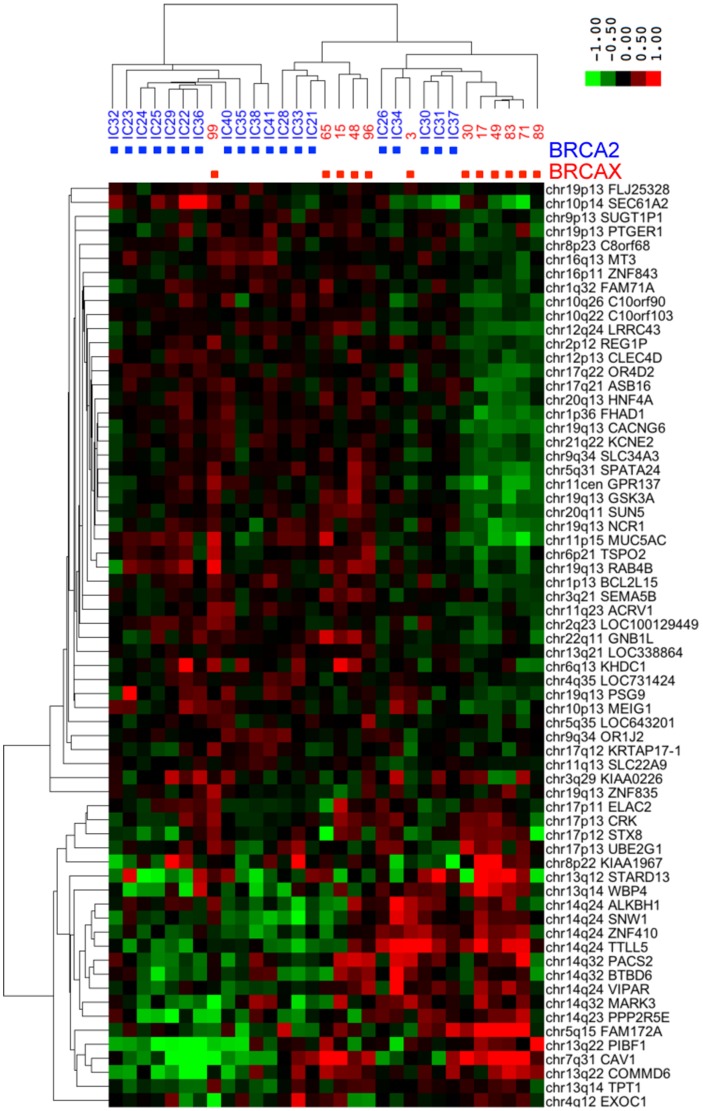
Unsupervised hierarchical clustering of the 66 BRCA2 signature genes in the validation set.There are 19 BRCA2-mutant tumors and 12 BRCAX tumors. The lower left quadrant contains many genes on 13q and 14q that show reduced expression in BRCA2 tumors.